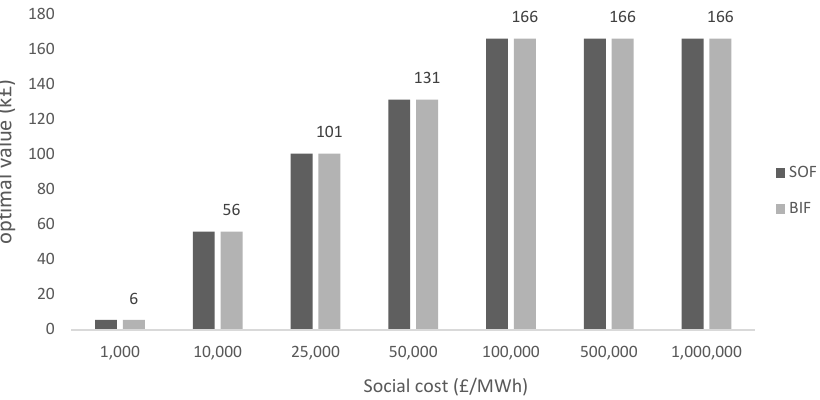
Figure 16. Optimal total expected system cost as a function of social cost, under SOF and BIF. In almost all cases the optimal solutions obtained using SOF and BIF are